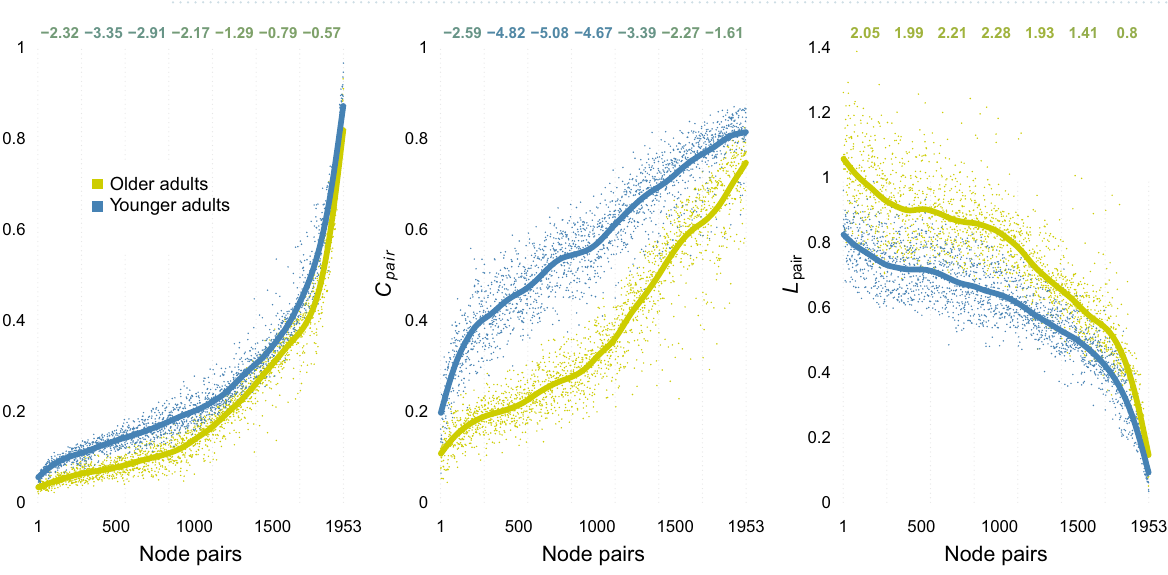
Figure 5. Differences in the macroscopic structure of younger and older adults’ similarity rating networks. Blue and yellow circles, in panel 1, correspond to younger and older adults, respectively. In panels 2 to 4, light blue circles and dark blue circles correspond to differences between the younger and older adults’ networks derived from weighted and unweighted networks, respectively. Error bars show 95% bootstrapped confidence intervals. Note: | E | - Proportion of edges relative to fully-connected graph; (cid:31) (cid:31) s (cid:30) , (cid:31) (cid:31) k (cid:30) - Differences in average strengths/degrees (unweighted); (cid:31) C w , (cid:31) C - Difference in average clustering coefficients of weighted/unweighted networks; (cid:31) L w , (cid:31) L - Difference in average shortest path lengths of weighted/unweighted networks.